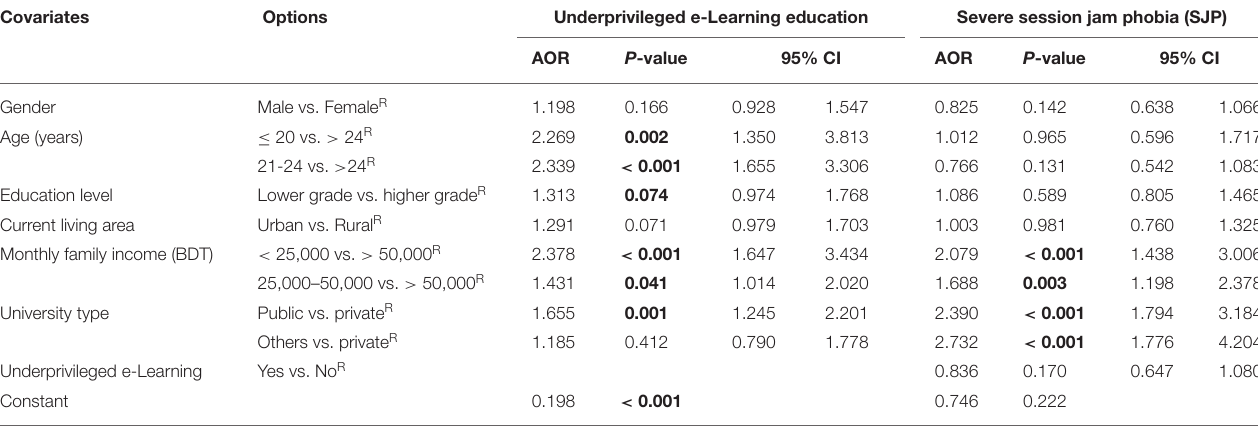
TABLE 3 | Logistic regression analysis for finding potential factors associated with underprivileged e-Learning education and severe session jam phobia (SJP) among university students following prolonged COVID-19 lockdown in Bangladesh. Covariates